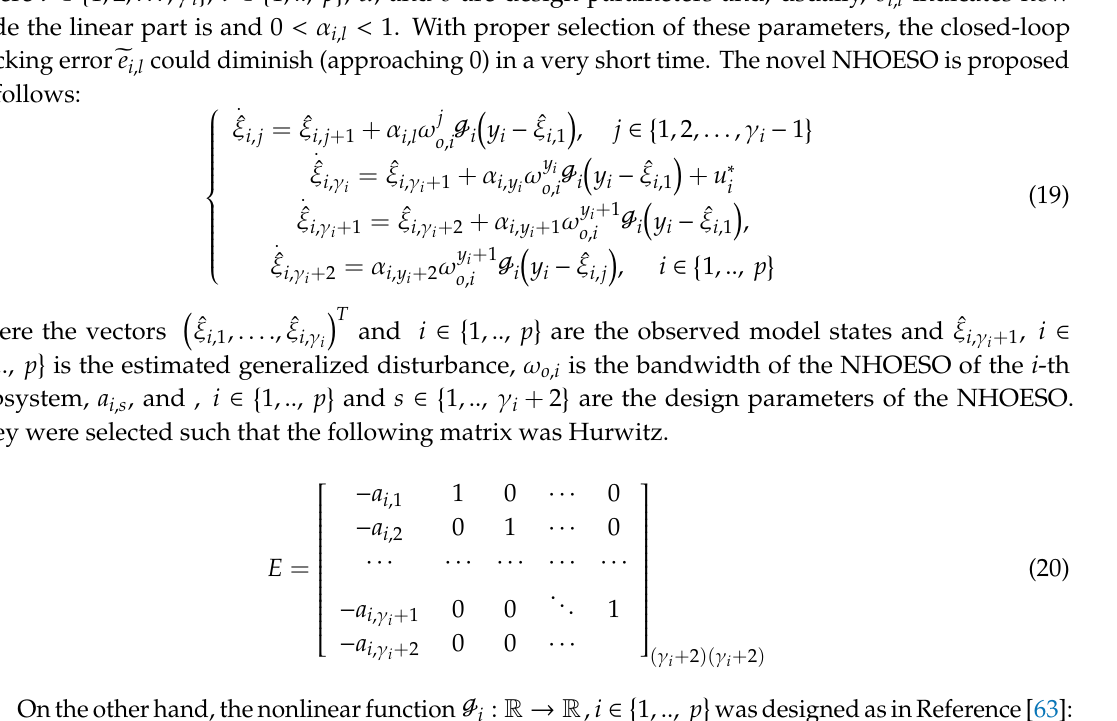
Figure 5. The proposed decentralized ADRC control scheme, where each ADRC block involves a SISO connection of TD, NLSEF, and ESO, as in Figure